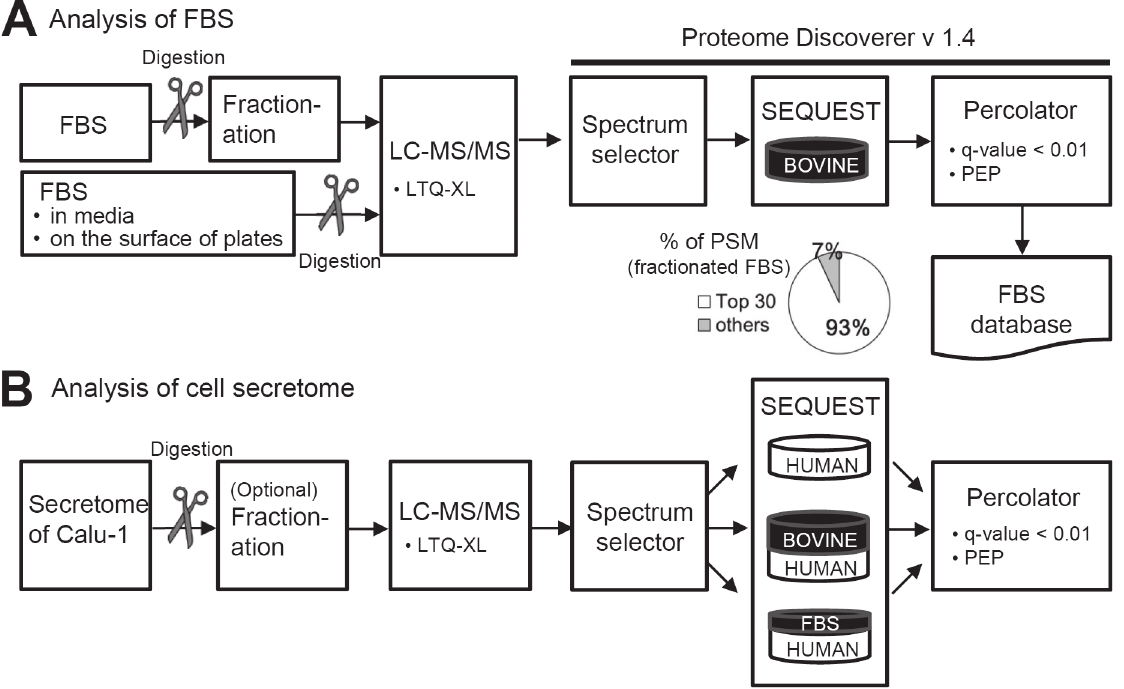
Fig 1. Schematic workflow for the proteome analysis of (A) fetal bovine serum (FBS) and (B) cell secretome. (A) FBS by itself as well as the residual FBS in the conditioned media or on the surface of the culture plate were analyzed. MS/MS data were compared against a bovine sequence database and the resultant protein list was used for the construction of an FBS database. (B) MS/MS data from cell secretome analysis were compared against various databases including human, human plus bovine and human plus FBS